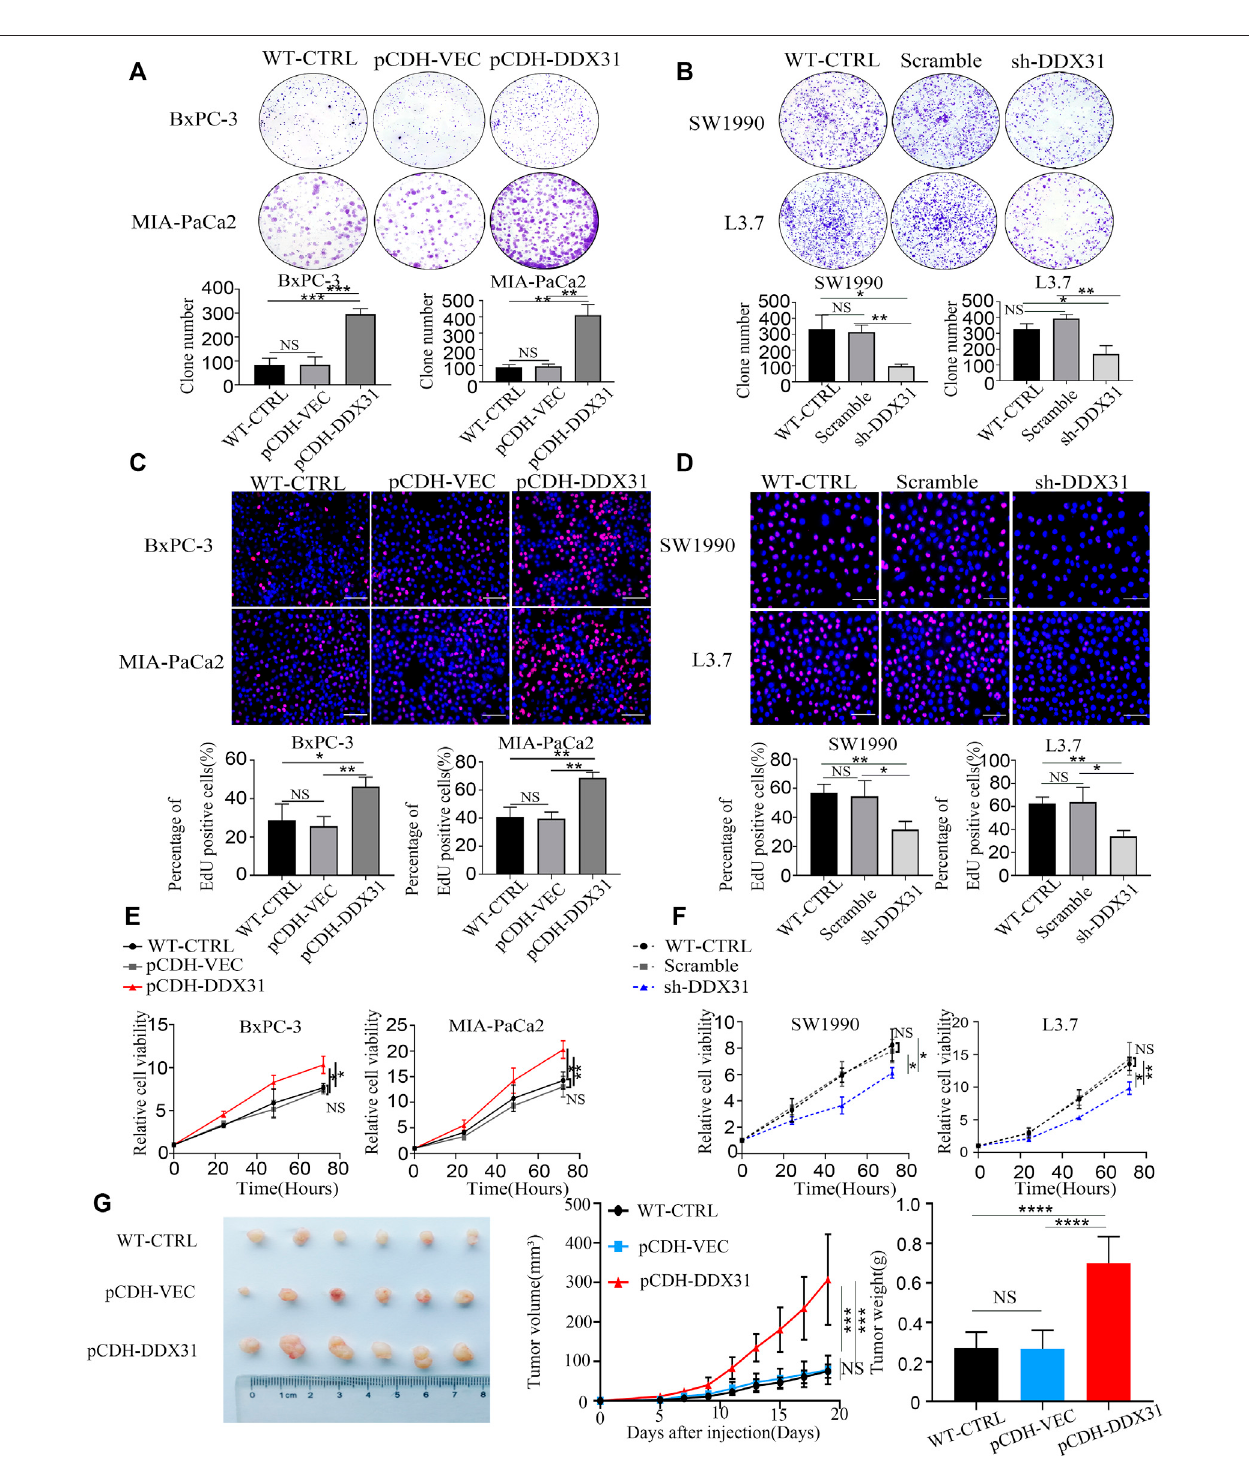
FIGURE 7 | DDX31 promoted PDAC cell proliferation and cell viability. (A,D) : Colony formation assays were performed in the indicated cell lines. Representative images and statistical analysis are shown (overexpression, left; knockdown, right). (B,E) : EdU staining assays (bar = 200 μ m) were conducted in indicated cell lines. Representative images and statistical analysis are shown. (C,F) : CCK-8 assays were performed to test the DDX31 function on cell viability in indicated cell lines. Representative growth curves are shown. (G) : In vivo subcutaneous tumor model was used to determine the role of DDX31 in the cellular proliferation of BxPC-3 (infectedwithpCDH- DDX31 andpCDH-VECTORlentivirus).Miceweresacri fi cedafter19 days;thevolumeandmassofharvested tumorsweremeasuredthreetimesa week. Each experiment was independently repeated three times, and the representative results are shown. Unpaired Student ’ s t-test was used for (A – G) analysis. * p < 0.05, ** p < 0.01, and NS means non signi fi cant.